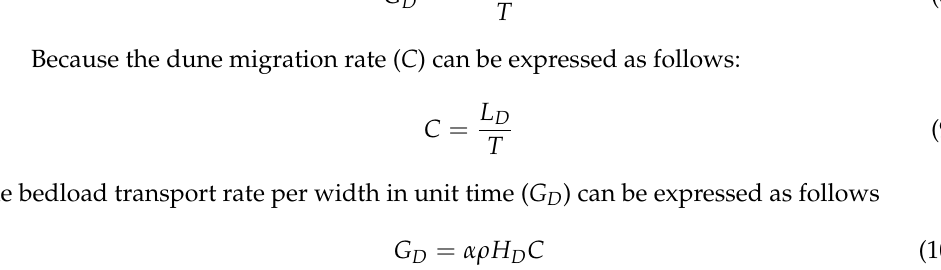
Figure 3. ( A – E ) The longitudinal profiles (black line) (left axis) and channel slope along the channel thalweg (green line) (right axis) of the Yangtze River Estuary during 1983, 1998, 2002, 2010, and 2018. ( F ) Changes in thalweg elevation of the Yangtze River Estuary during 1983–2018. The starting point of the horizontal axis is 4 km upstream of Wusong station (Figure 1C). 4.2. Spatiotemporal Variation of the SCSP Bed Elevation and the Riverbed Erosion and Deposition Patterns Based on the survey charts between 1983 and 2018, a 3D contour map for the average bed elevation of the SCSP was constructed by kriging interpolation of average bed eleva- tion values during the study period (Figure 4A) and the longitudinal profiles of the SCSP at different time are shown in Figure 4B. We found that there is no significant change in average bed elevation in the past 35 years along the entire 80 km deltaic channel. Specifi- cally, the average bed elevation of the SCSP is − 6.90 m, − 6.67 m, − 6.36 m, − 6.83 m, and − 6.84 m, respectively. However, we found that the upper boundary of maximum turbidity moves seaward (Figure 4B,C). Our assessment also shows that the SCSP has undergone excess riverbed deposition from 1983 to 2018 and the total amount of aggradation in the past 35 years over the entire length of the active channel is 1.62 × 10 7 m 3 . Specifically, there was a slight deposition with a net deposition rate of 0.91 × 10 7 m 3 /yr between 1983 and 1998 (Figure 5A). During 1999–2002, there was a sequential deposition with a net deposi- tion rate of 3.31 × 10 7 m 3 /yr (Figure 5B). However, after 2002, the SCSP experienced